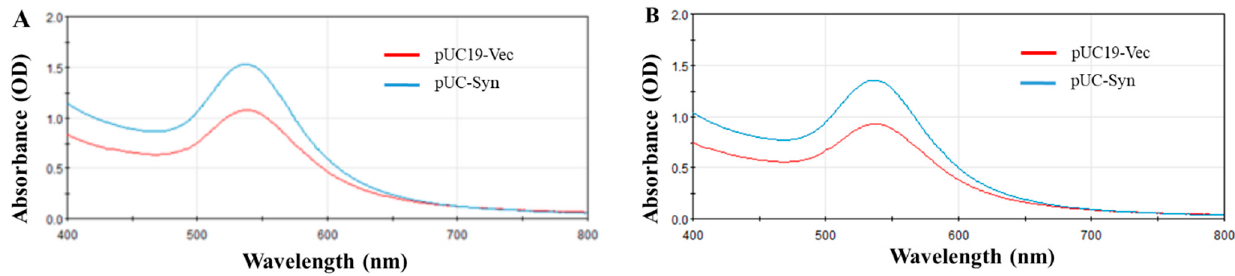
Figure 2. Synthesis and yield of gold nanoparticles by soluble intracellular extracts from bacteria. ( A ). Soluble intracellular reaction mix after 7 days of incubation with 2 mM HAuCl 4 . ( B ). Supernatant collected after centrifugation of the reaction mix in A at 3000 g for 5 min. ( C ). Nanoparticle pellets obtained after further centrifuging the supernatant in ( B ) at 17,000 × g . ( D ). Dry weight of nanoparticle pellets collected from 100 mL cell-free reaction mix after centrifugation at 3000 g and 17,000 g, respectively. n = 4. *: p < 0.05.